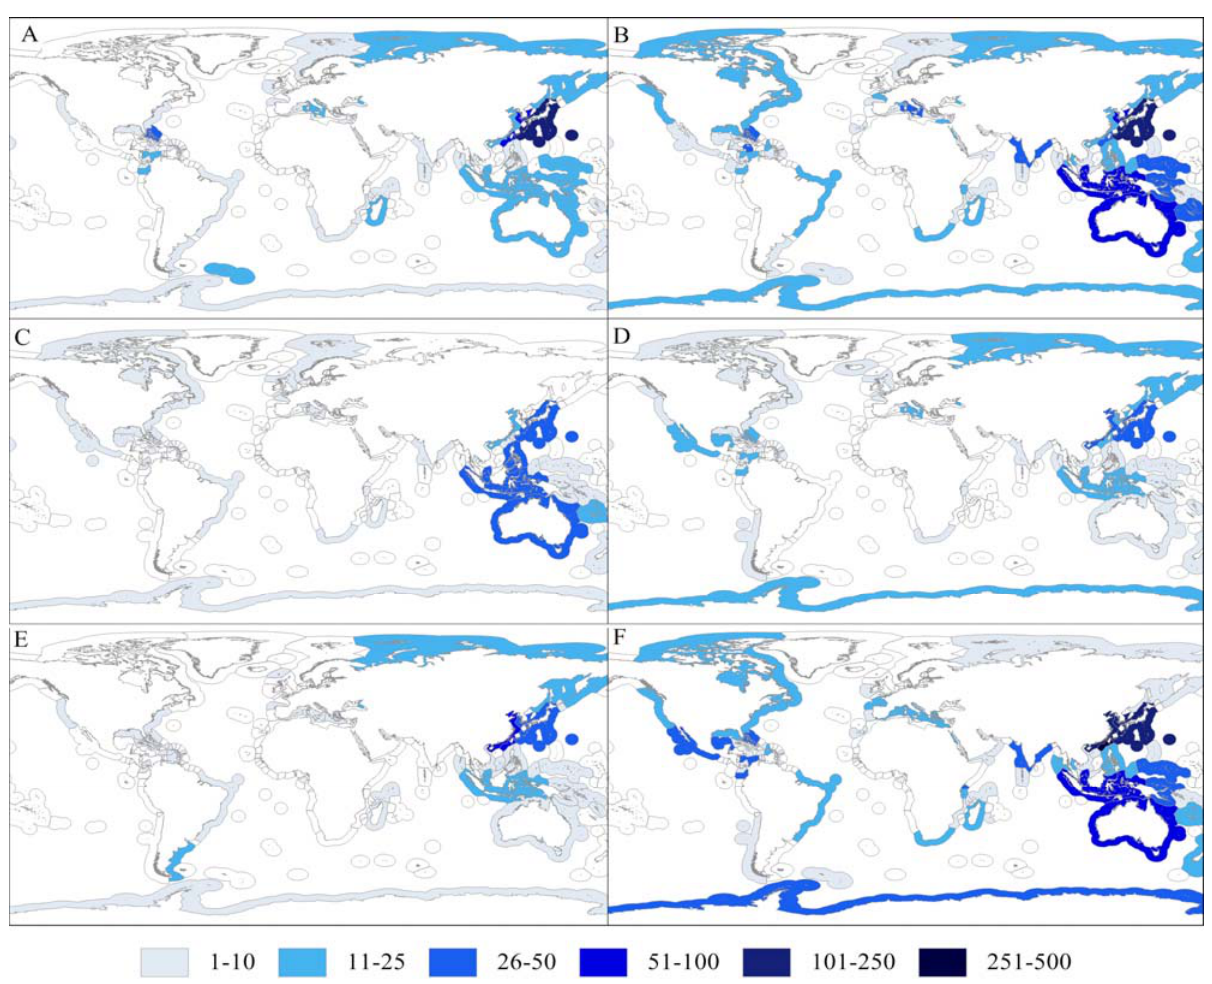
Figure 2. Exclusive Economic Zones. Number of new natural products discovered from marine invertebrates for world Economic Exclusive Zones (EEZ) between 2000 and 2009 according with chemical groups: ( A ) terpenoids; ( B ) alkaloids; ( C ) aliphatic; ( D ) steroids; ( E ) carbohydrates; ( F ) amino acids and